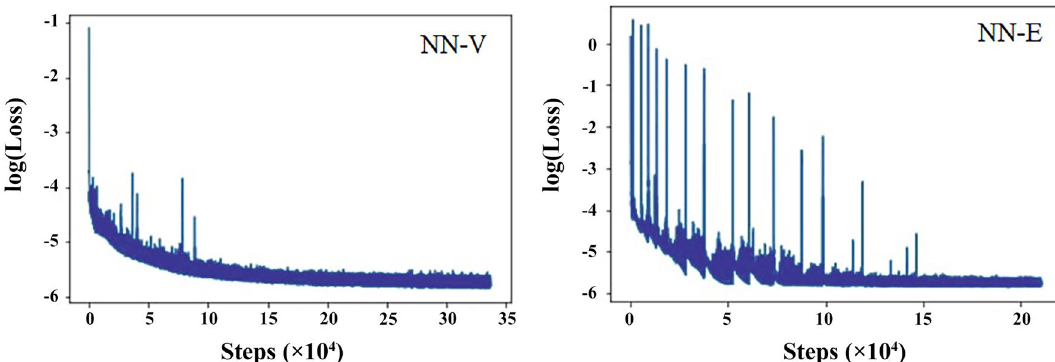
Figure 2. Training curves of XC neural network. The left one corresponds to NN-V training, where log(Loss) is the logarithm of loss (2). The right one corresponds to NN-E training where log(Loss) is the logarithm of loss with boundary conditions (3). Outliers on the training curves are related with adjustable learning rate used for optimization algorithm.